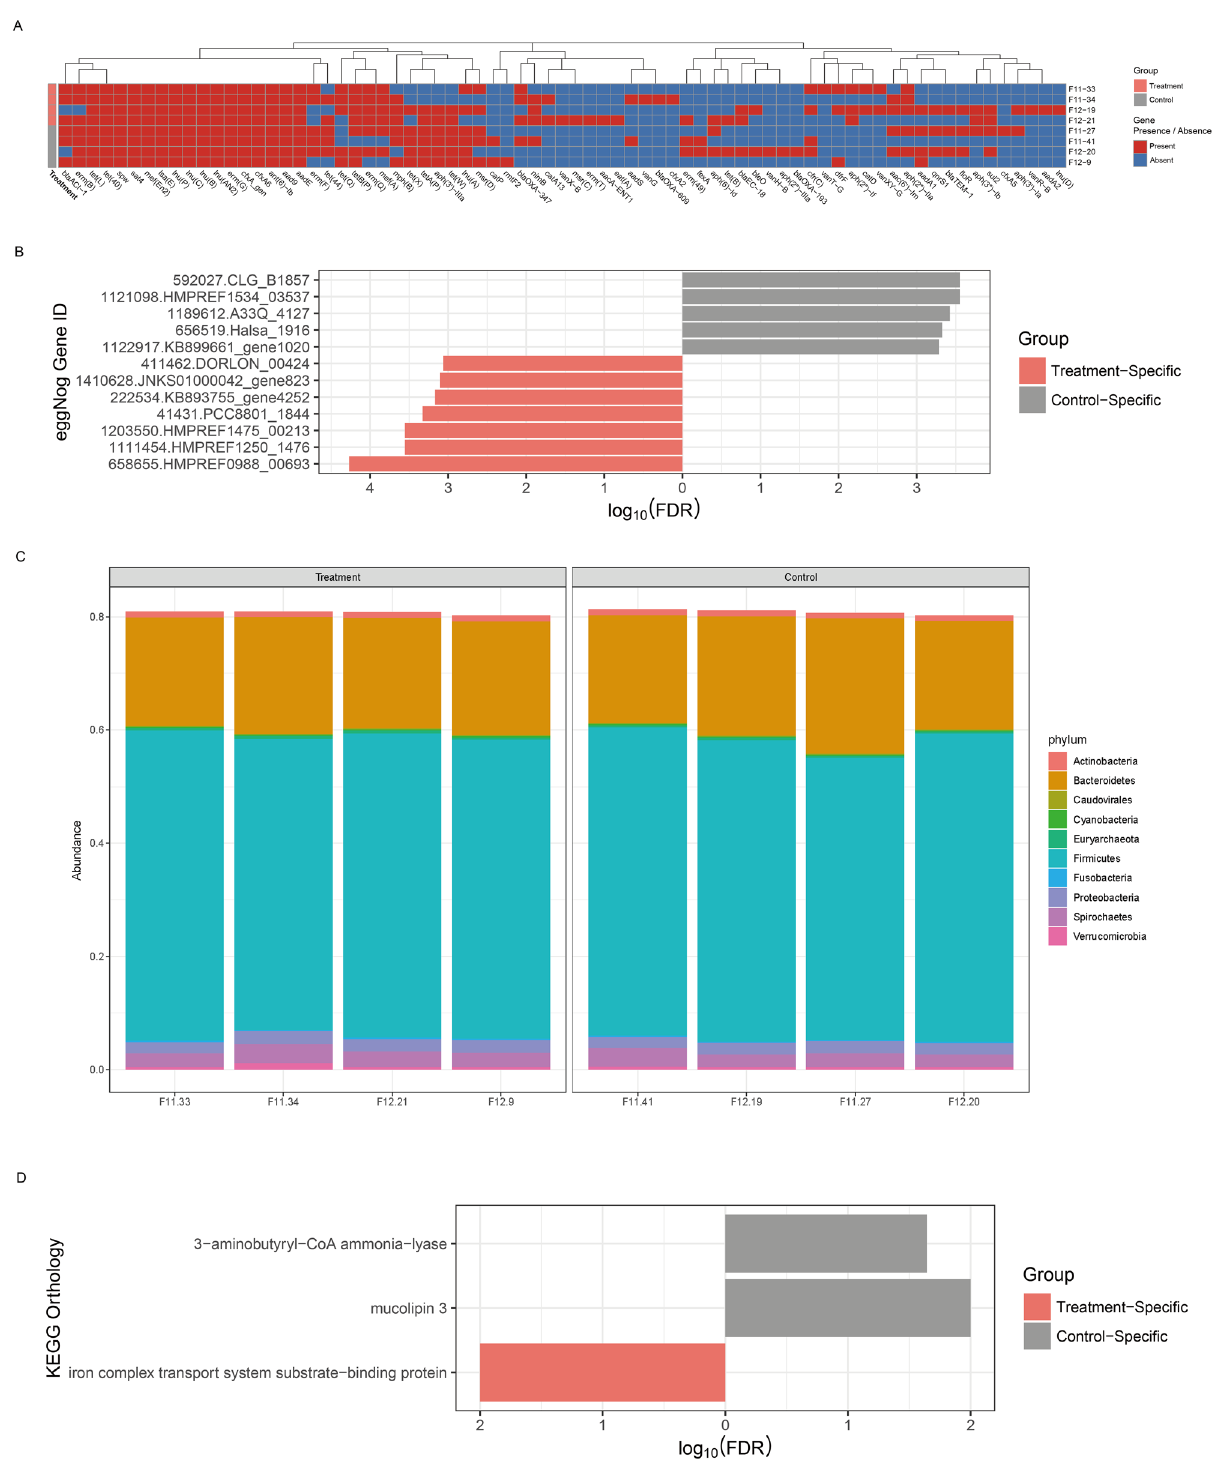
Figure 3. Functional Profiling from shotgun metagenome sequencing. ( A ) Antibiotic resistance genes identified from each sample. ( B ) Bar chart for differentially abundant genes between groups. FDR P-value 0.0005 was used as threshold. ( C ) Taxonomic composition profiling at gene-level. ( D ) Clusters of Orthologous Groups (COG) functional category profiling results. ( E ) Bar chart for differentially abundant KEGG Ortholog functional category. Used FDR P-value was